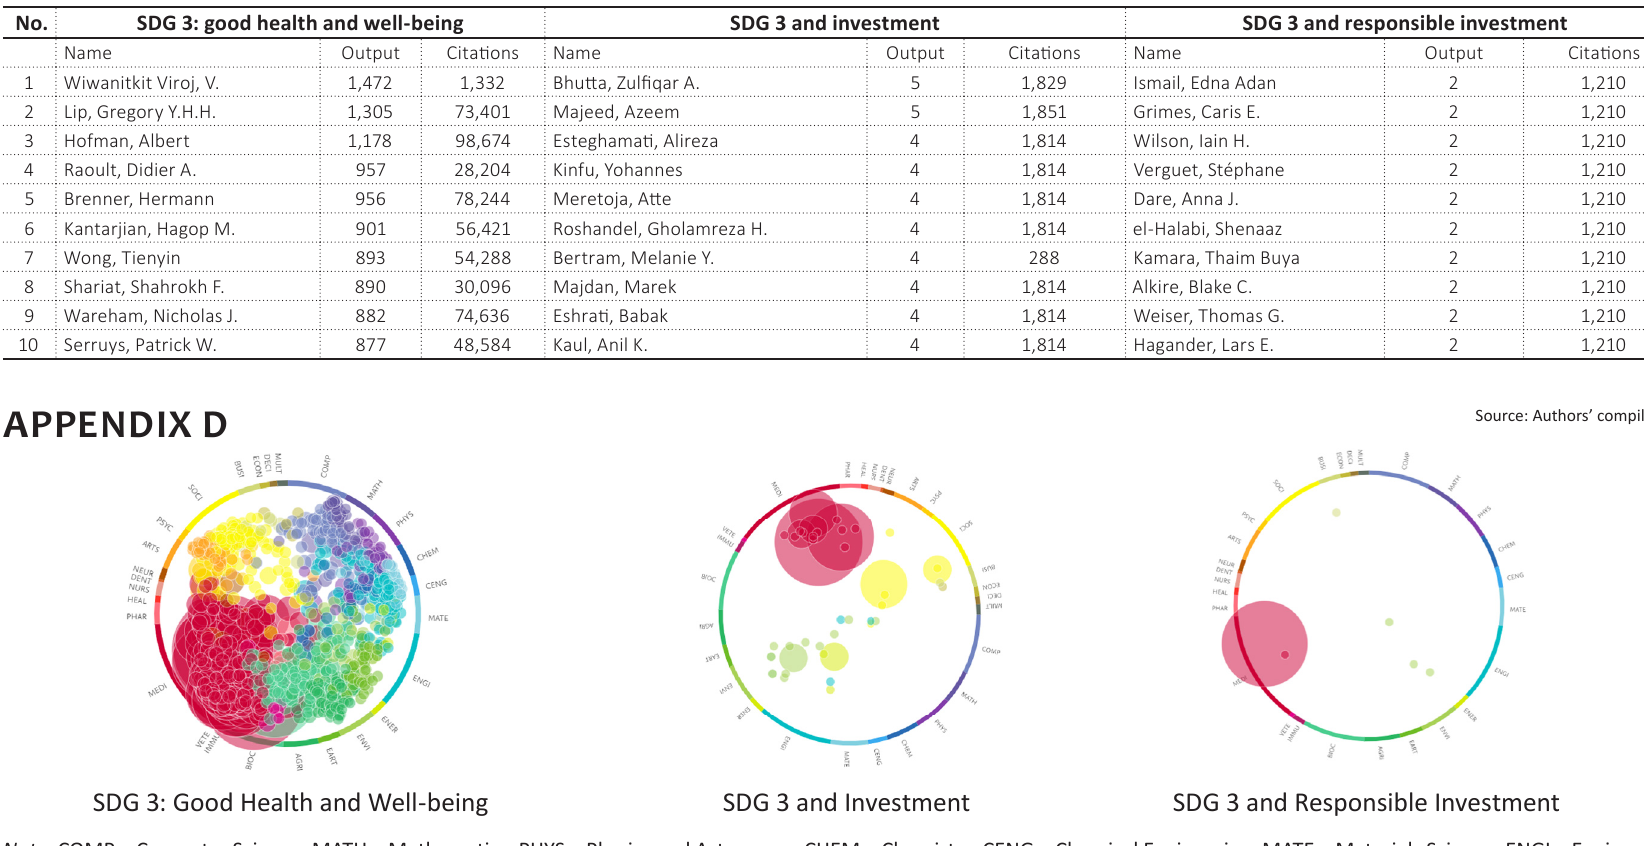
Figure D1. Topics and topics clusters in each research area,